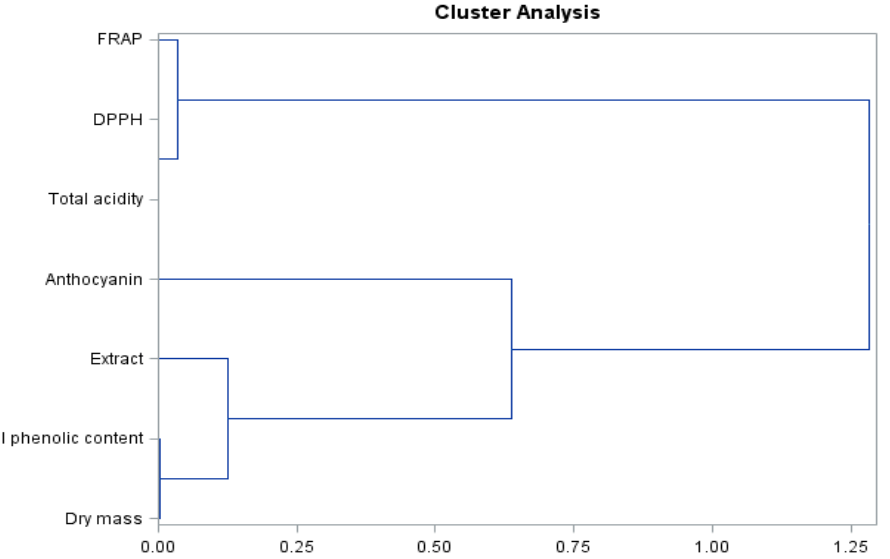
Figure 6. Branching-tree diagram for biologically active compounds and antioxidant activity of ‘Ein- set Seedless’ fruits irrespective of the concentration of gibberellic acid. ‘Einset Seedless’ fruits irrespective of the concentration of gibberellic acid.